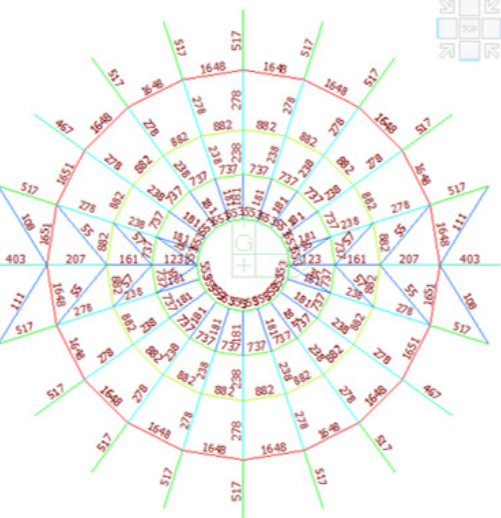
Figure 19. Tension cloud diagram of cable structure after tension.